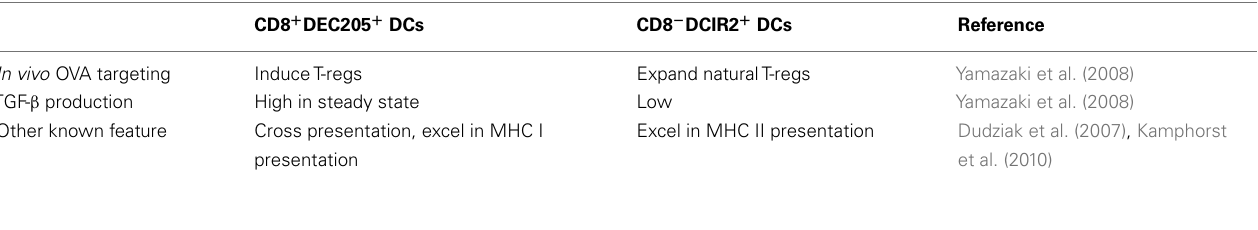
Table 1 | Foxp3 + T-regs and classical spleen DCs in the steady